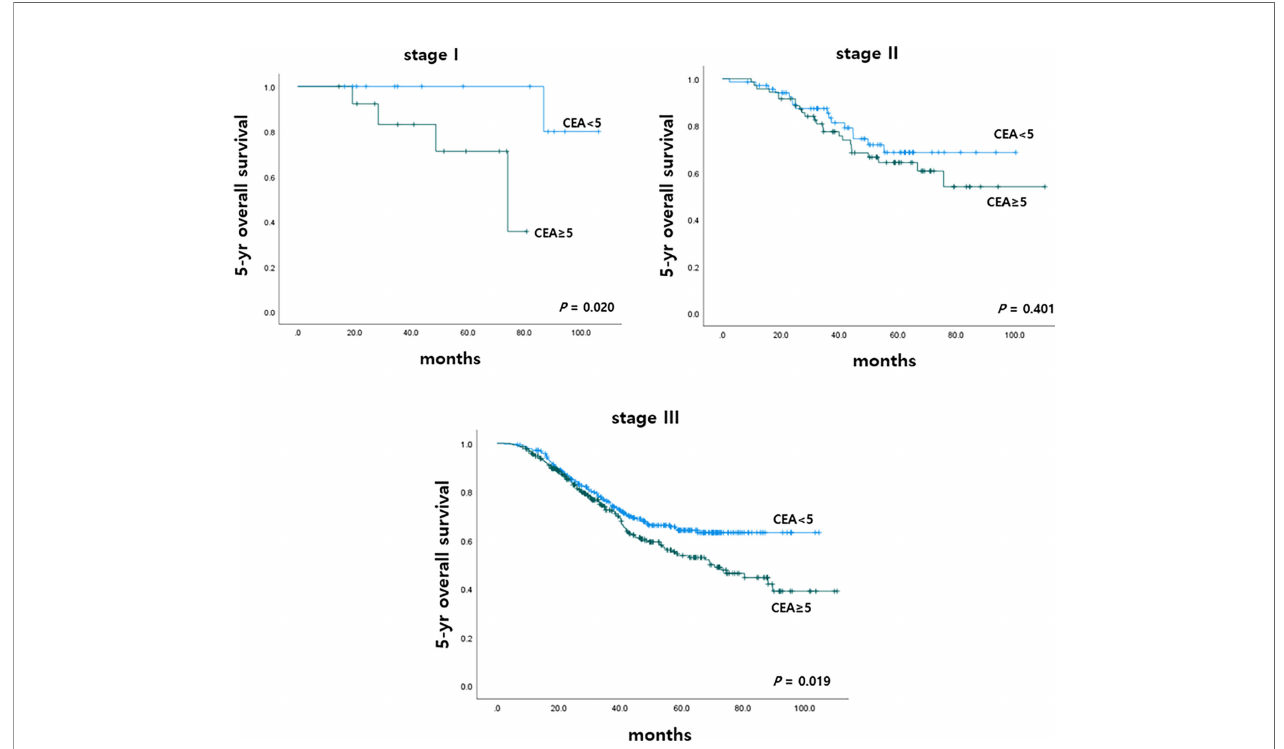
FIGURE 3 | Five-year overall survival according to CEA level at the time of recurrence in matched patients.